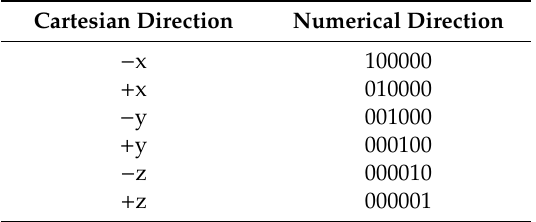
Table 2. Removal Table 2. Removal Direction.